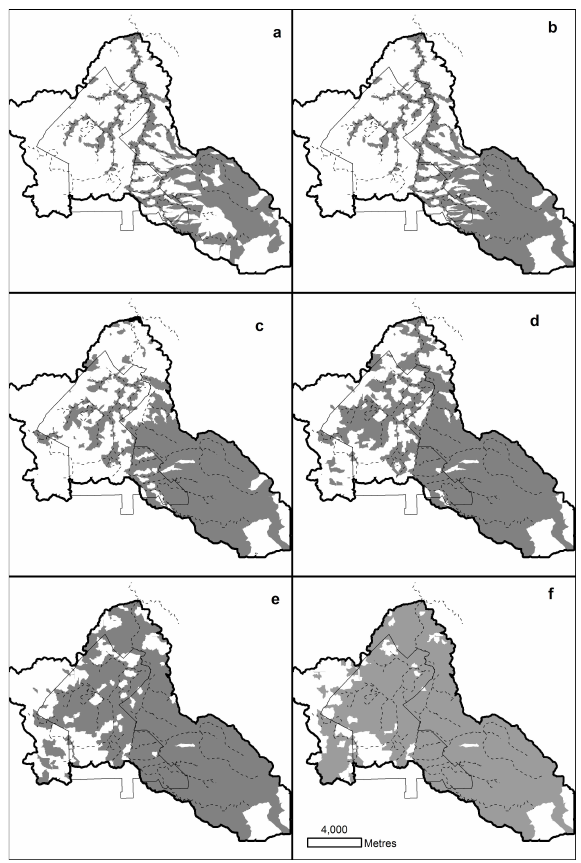
Fig. 9. Contributing catchments during the storage recovery stage under (a) 10mm, (c) 48mm, (e) 137mm rainfall event; and dur- ing the storage deficiency stage under (b) 10mm, (d) 48mm, (f) 137mm rainfall